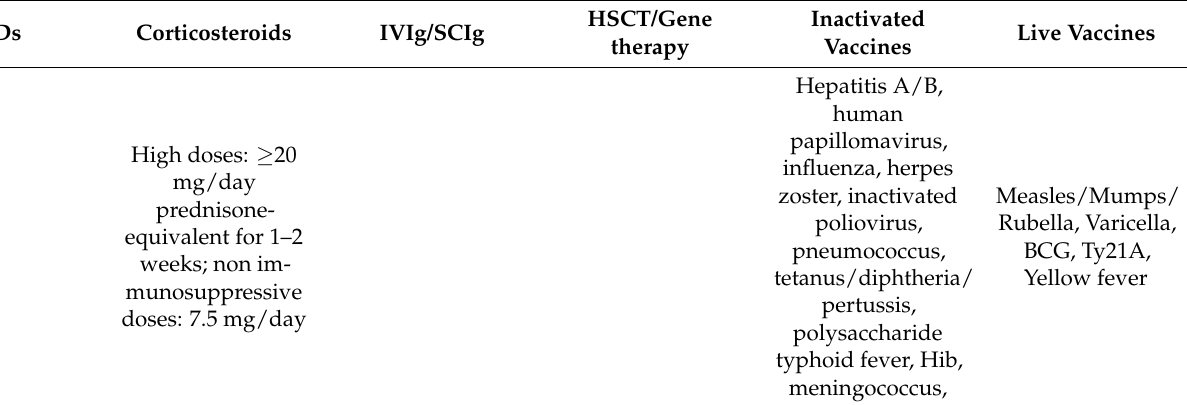
Table 2. Inactivated and live traditional vaccines (not anti-COVID-19) in patients with PIDs and influence of the relative